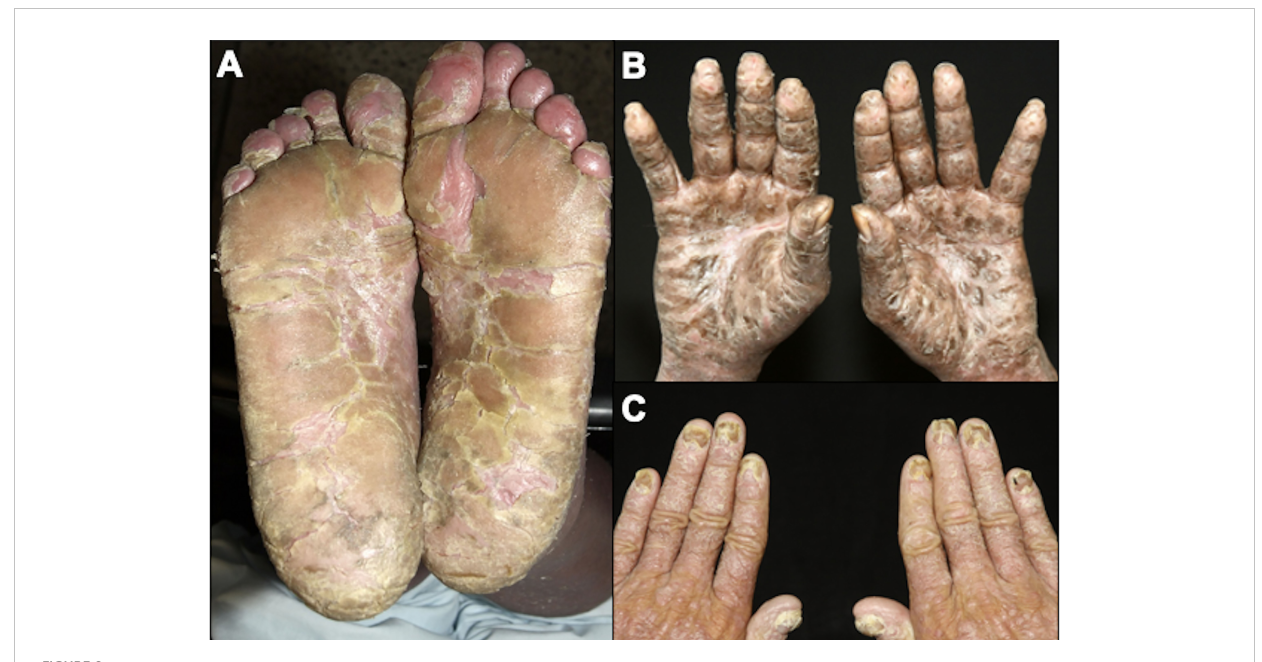
FIGURE 9 Se ́ zary syndrome. Plantar (A) and palmar (B) keratoderma, onychodystrophy (C) .